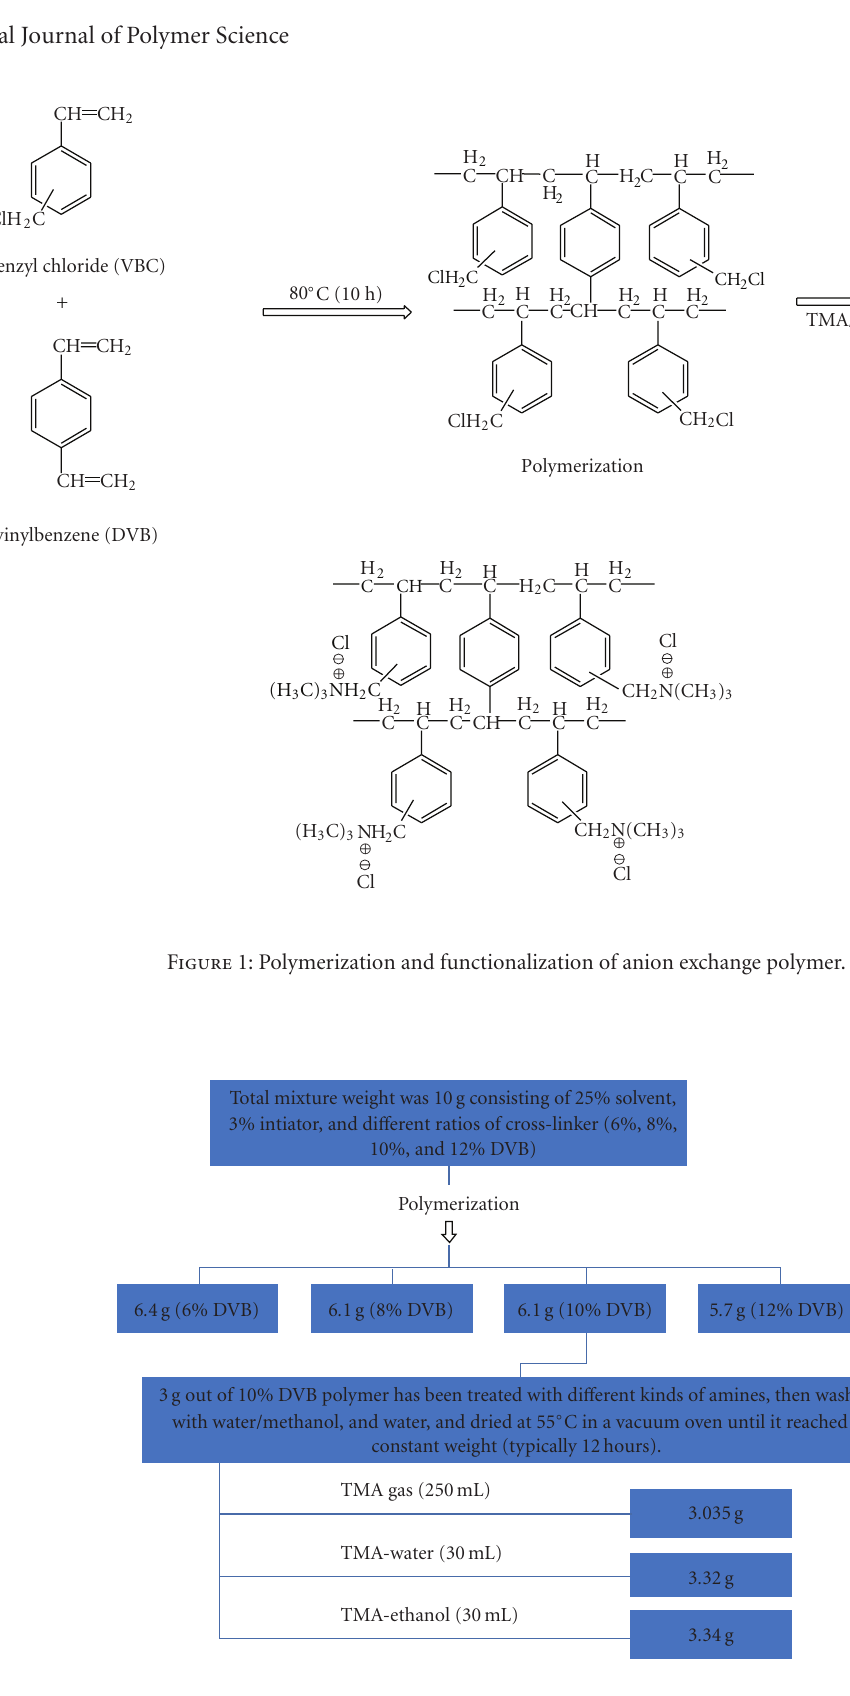
Figure 2: Scheme showing the preparing procedures while di ff erent factors have been